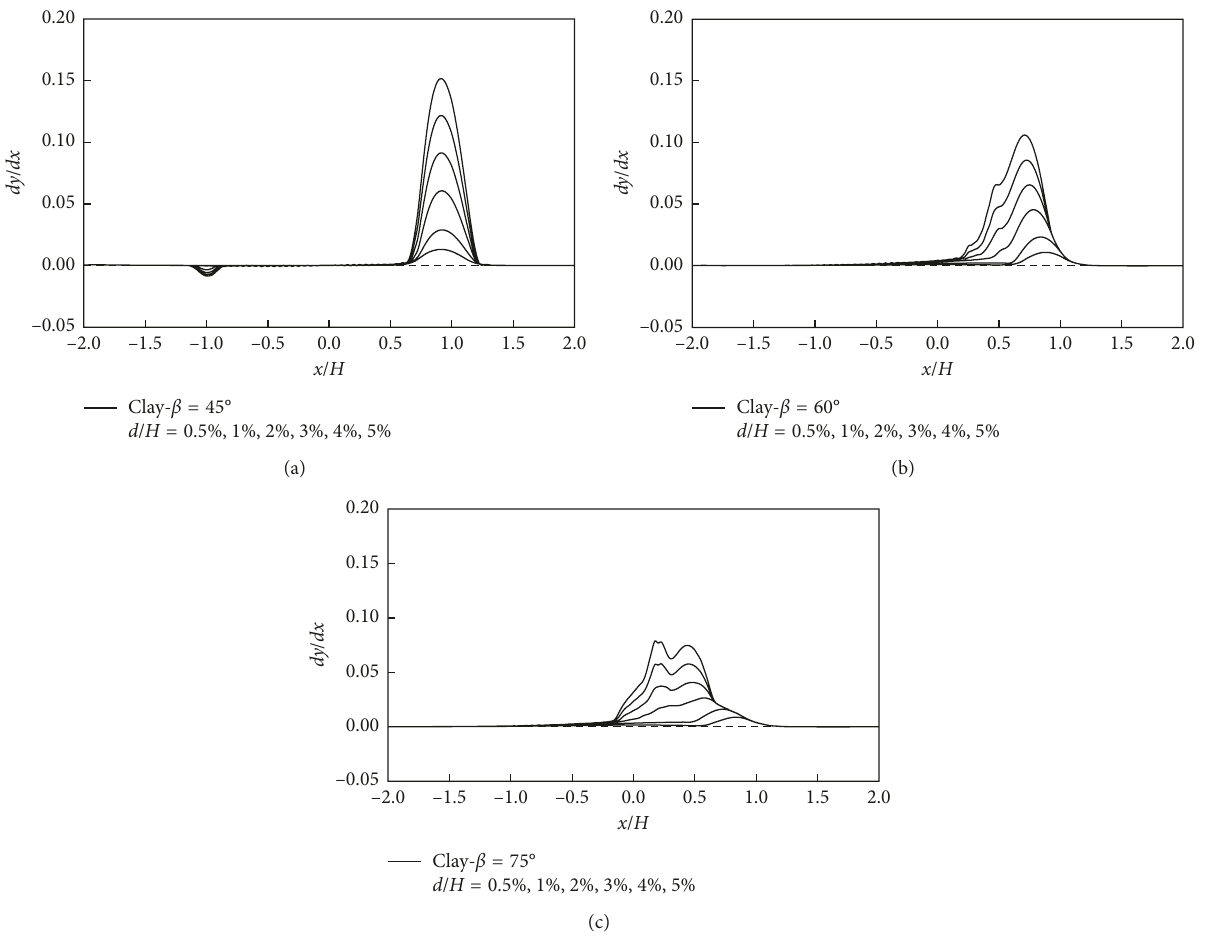
Figure 13: The ground incline curve with different dip angles for the normal fault in clay: (a) 45 ° , (b) 60 ° , and (c) 75 °